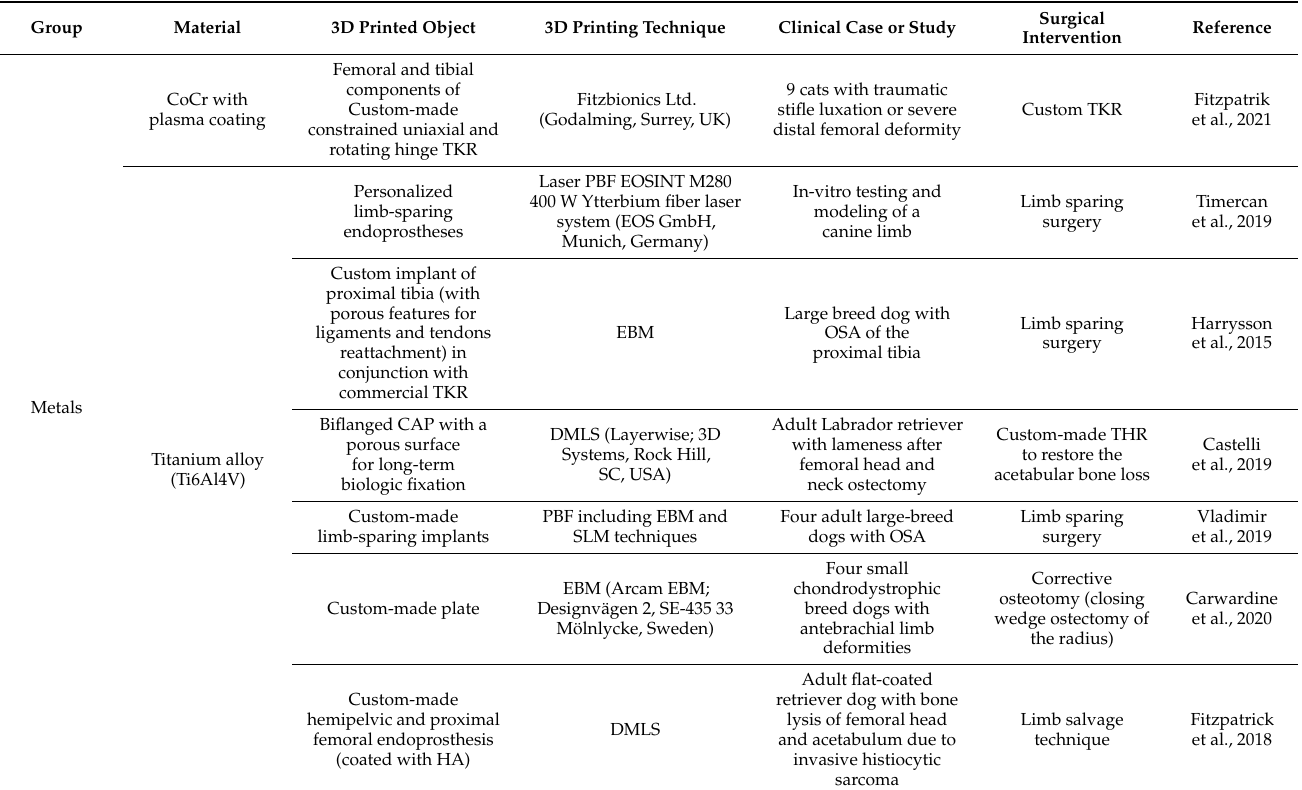
Table 1. Examples of 3D printable materials used for receiver-specific orthopedic application in recent publications in veterinary